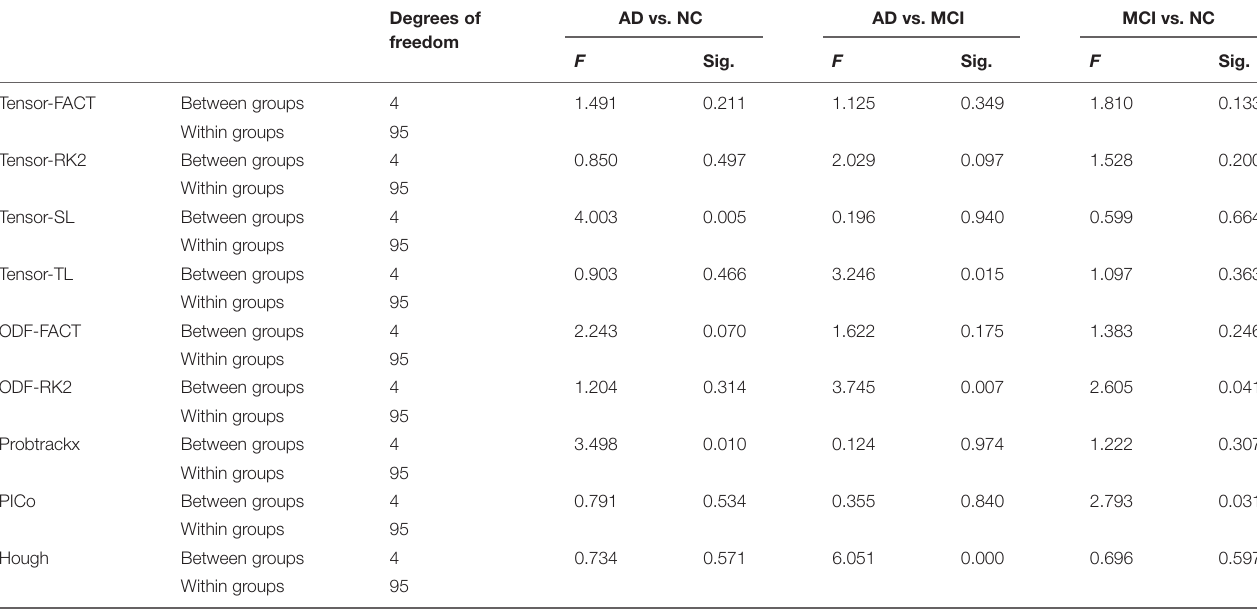
TABLE 8A | One-way ANOVA on the classification performances across five feature methods for nine tractography algorithms in three diagnostic tasks. Degrees of AD vs. NC AD vs. MCI MCI vs. NC freedom F Sig. F Sig. F